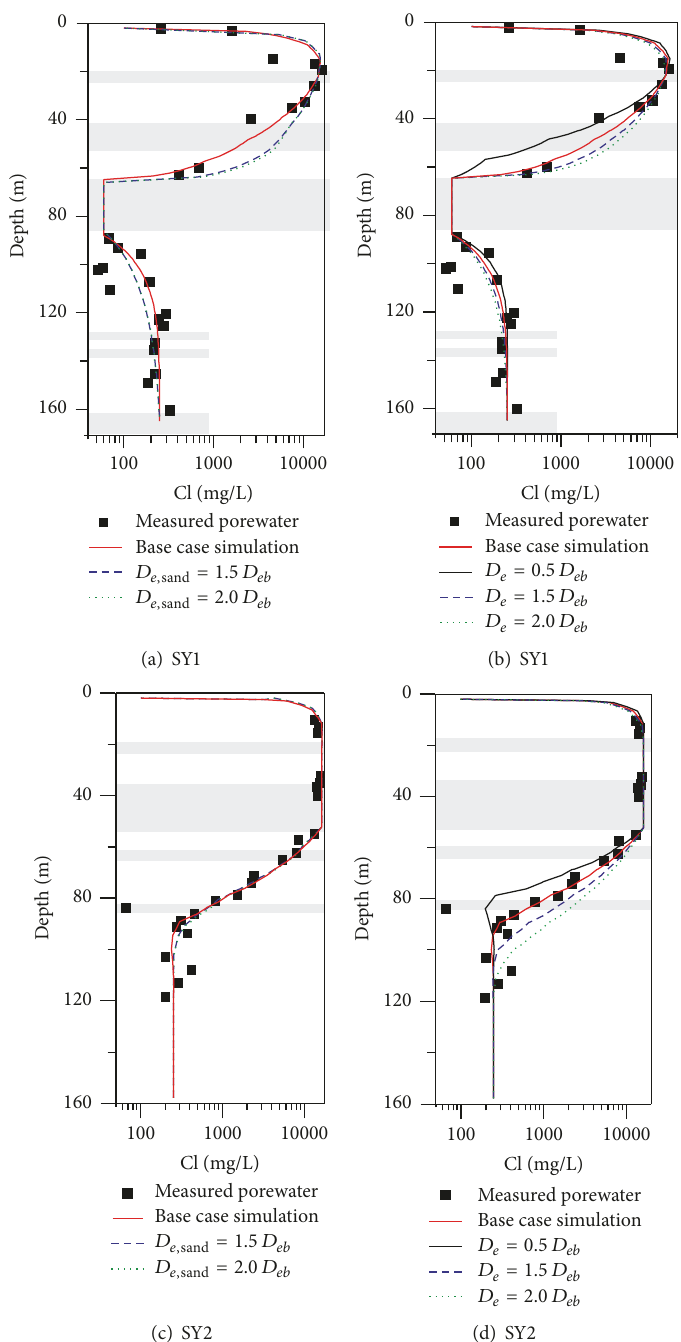
Figure 9: Results of 𝐷 𝑒 sensitivity analyses on simulations; (a) and (c) show the simulation profiles of the two boreholes through simply modifying effective diffusion coefficients of sand layers ( 𝐷 𝑒, sand ) by various increase factors. (b) and (d) show the modified simulation tracer profiles of the two boreholes using various 𝐷 𝑒 for the whole profiles. 𝐷 𝑒𝑏 represents the 𝐷 𝑒 value applied for the base case simulation.